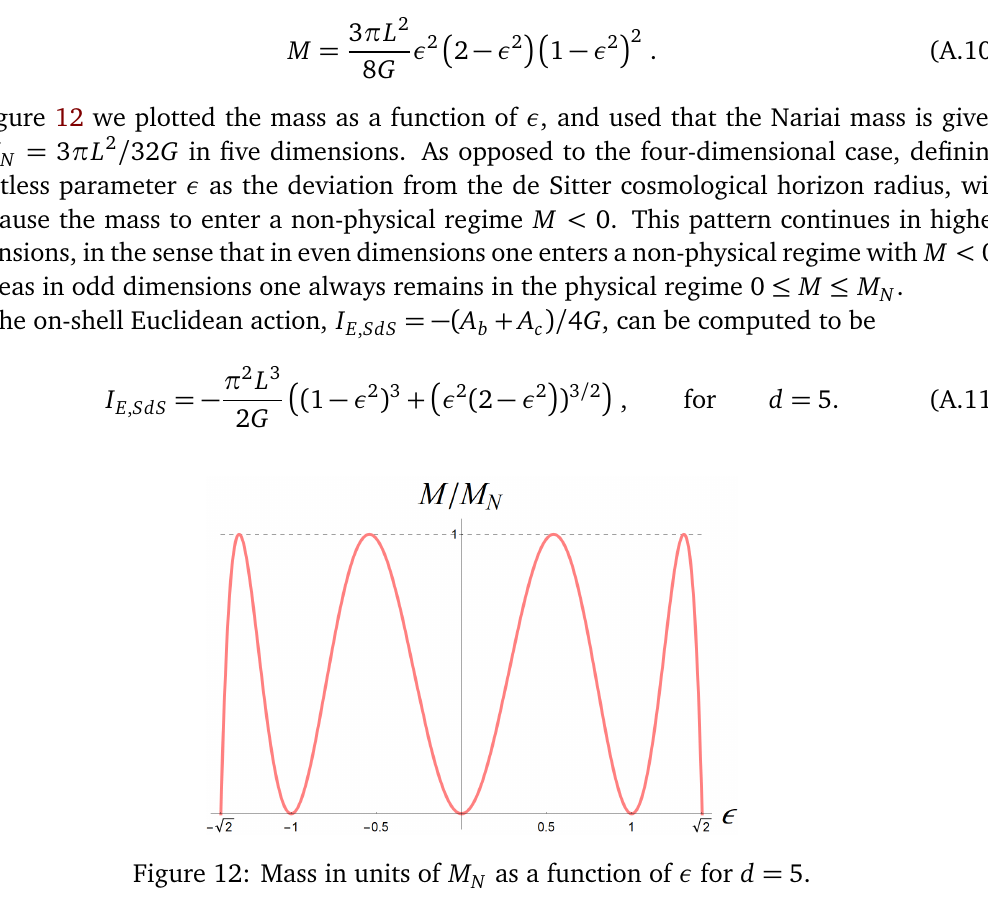
as a function of ε for d = N